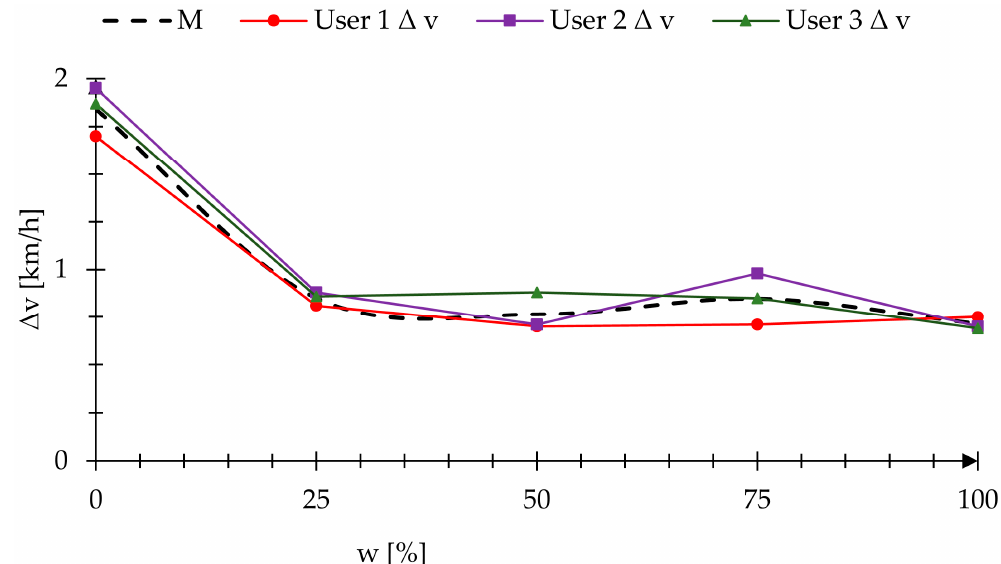
Figure 8. Graphs showing the maximum speed amplitude as a function of the assistance amplification coe ffi cient during the climb uphill as a function of the assistance amplification coe ffi cient for the hill-climbing assistance mode (t3).